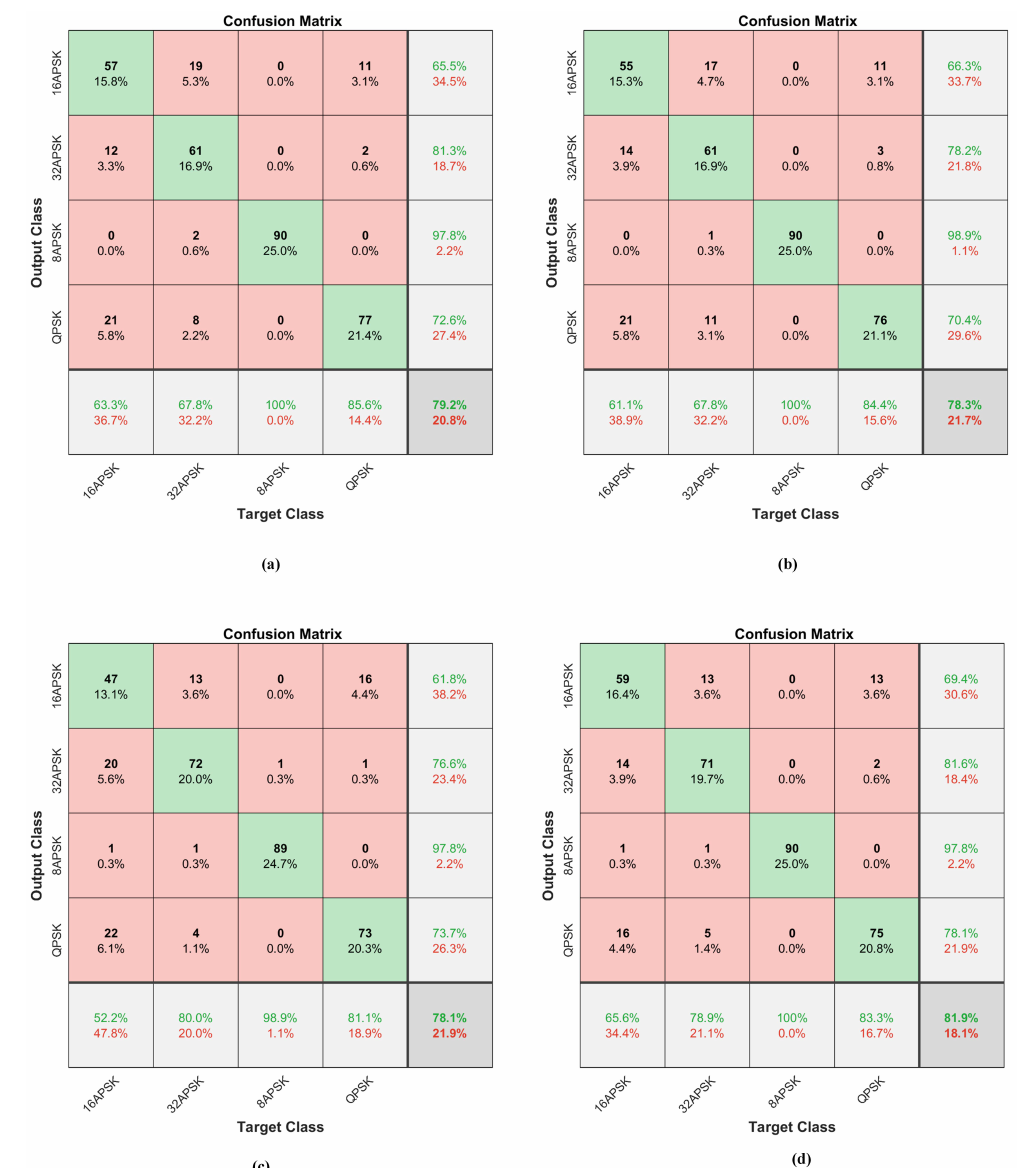
Figure 9. AMC results in the presence of CI (AMC4) using ( a ) AlexNet (79.20%), ( b ) VGG16 (87.30%), ( c ) GoogleNet (78.10%), and ( d ) ResNet18